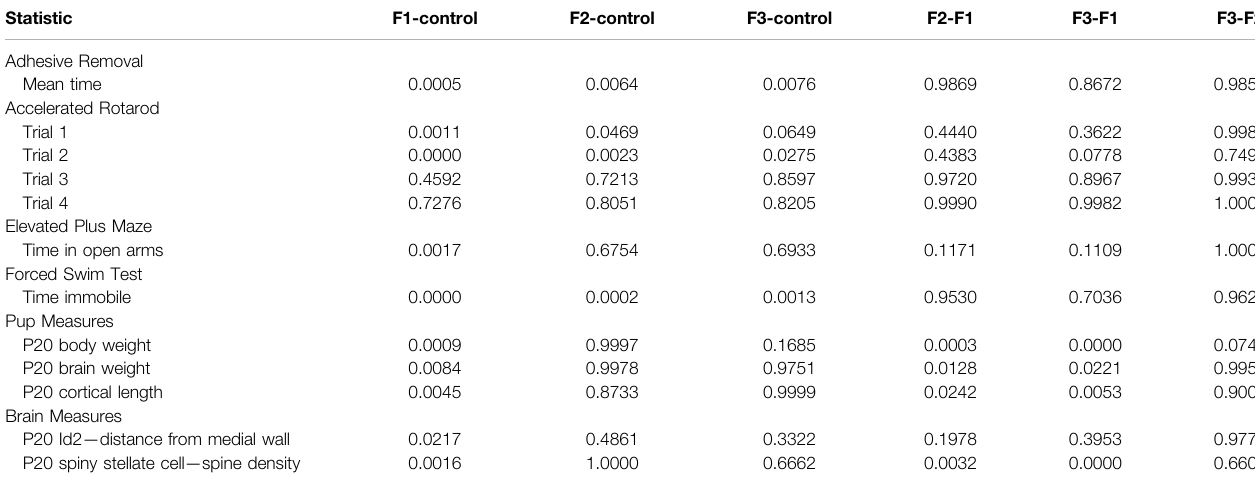
TABLE 3 | p value summaries for all pairwise comparisons for each statistical test.